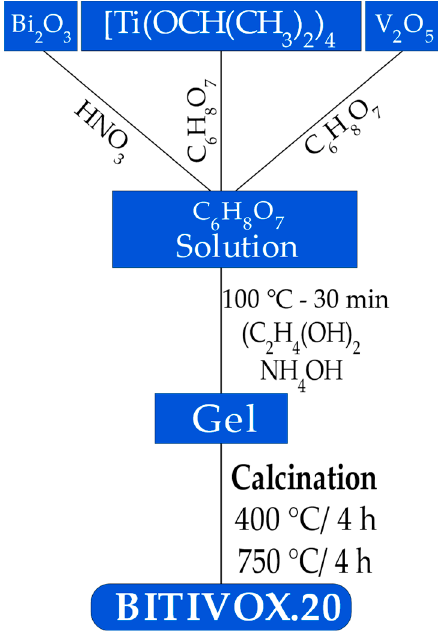
Figure 1. Time evolution of applied electric field and electric current through a BITIVOX pellet during 300 s at 800 °C. Inset: exploded view of the first 5 s under the electric field.